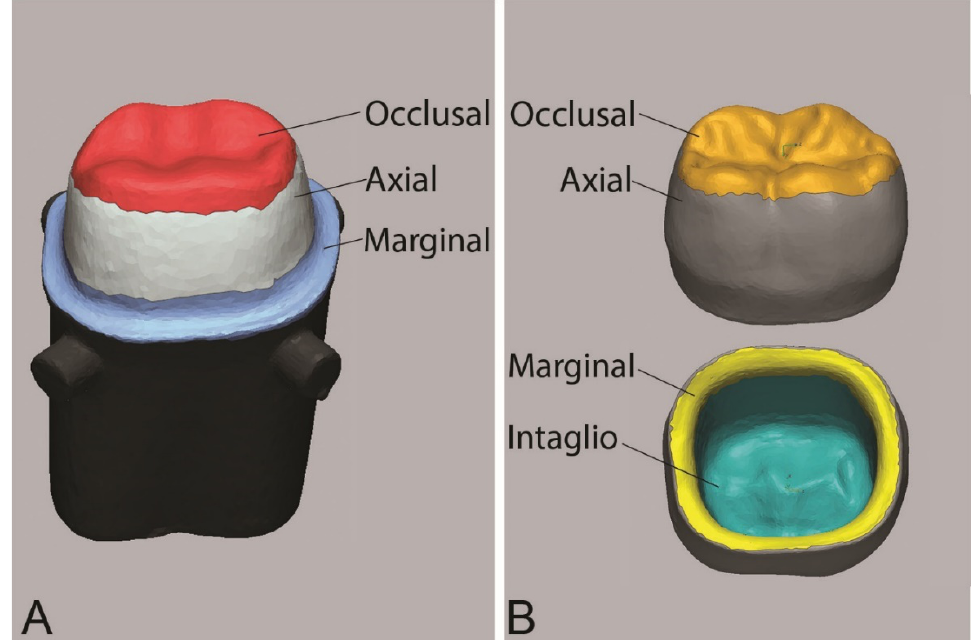
Figure 1 . ( A ) Areas of comparison for internal fit and marginal adaptation evaluation, ( B ) Areas of comparison for trueness and precision evaluation. comparison for trueness and precision